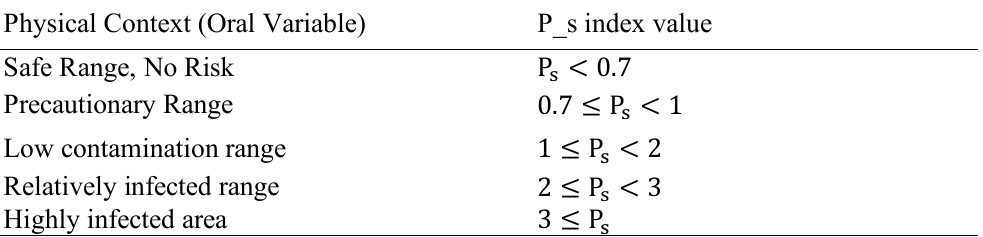
Table 6 . PS values and the corresponding concept in the Nemerow index for soil contamination with heavy